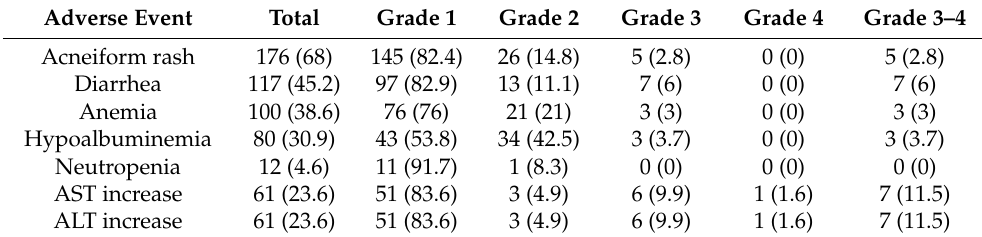
Table 2. Adverse events during treatment with tyrosine kinase inhibitors ( n =